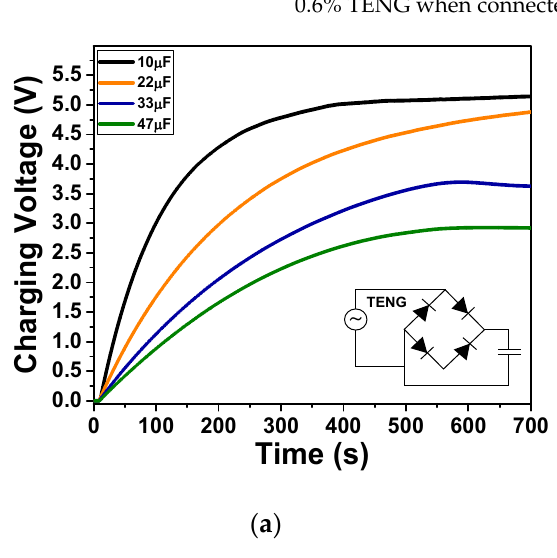
Figure 8. ( a ) Charging voltage profiles of capacitors charged by the electricity generated from fabricated TENG; ( b ) the TENG electrical output can instantaneously light up 44 green LEDs.